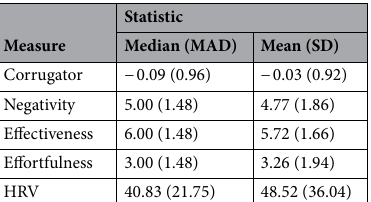
Table 1. Summary statistics of the collected measures. Median (MAD), median value with corresponding median absolute deviation. Mean (SD), mean value with corresponding standard